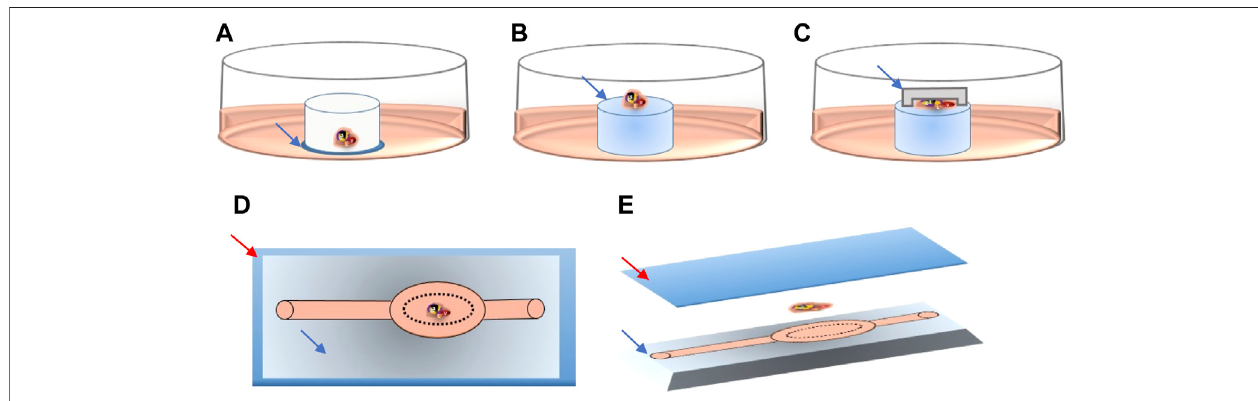
FIGURE 1 | Schematic detail of tissue location in the different culture systems. Culture medium is shown in pink in all systems. (A) Blue arrow pointing to the thin PTFE membrane, directly contacting the culture medium. (B) Blue arrow pointing to the agarose gel pillar. (C) Blue arrow pointing toPDMS cover chip deposited on top of the tissue fragment. (D) Upper view of the PDMS chip, red arrow pointing to the glass slide, blue arrow to the patterned PDMS chip. (E) 3D lateral view of the PDMS chip showing the glass slide (red arrow), tissue fragment and patterned PDMS chip (blue arrow).